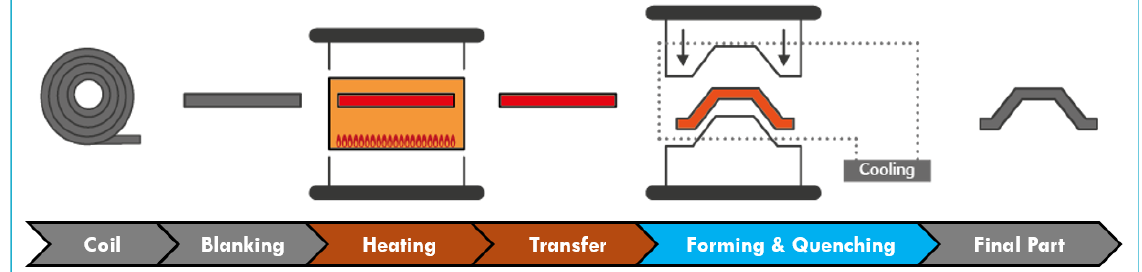
Figure 1. A Schematic of the Hot Stamping Process.